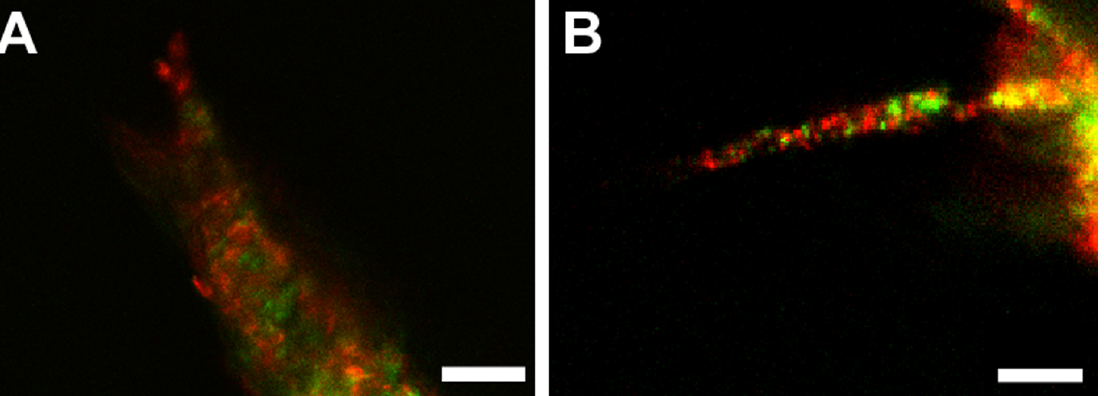
Figure 5. Coordinated cellular interactions of vascular sprout invasion within PEGDA hydrogels. Confocal images taken using 20 6 magnification at (A) 24 and (B) 48 hours post-aggregate placement in hydrogels. Fluorescently labeled endothelial cells appear in red and smooth muscle cells appear in green (scalebar=50 m m).